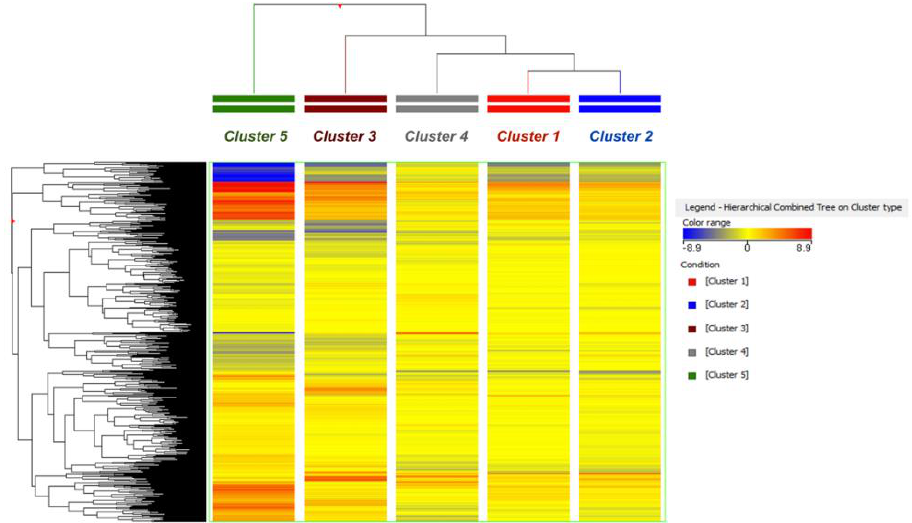
Figure 2. Unsupervised hierarchical clustering built considering the averaged milk metabolic profile outlined by the UHPLC-HRMS analysis.